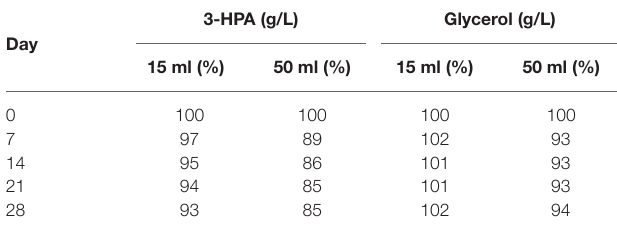
TABLE 3 | Average 3-HPA and glycerol content in the supernatant (in % of the initial value) after freeze-thaw cycles performed weekly for 28 days in 15 and 50 ml